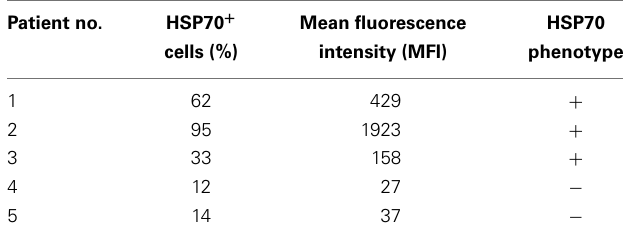
Table 1 | HSP70 membrane status in single cell suspensions of HCC tissue obtained from tumor patients . Patient